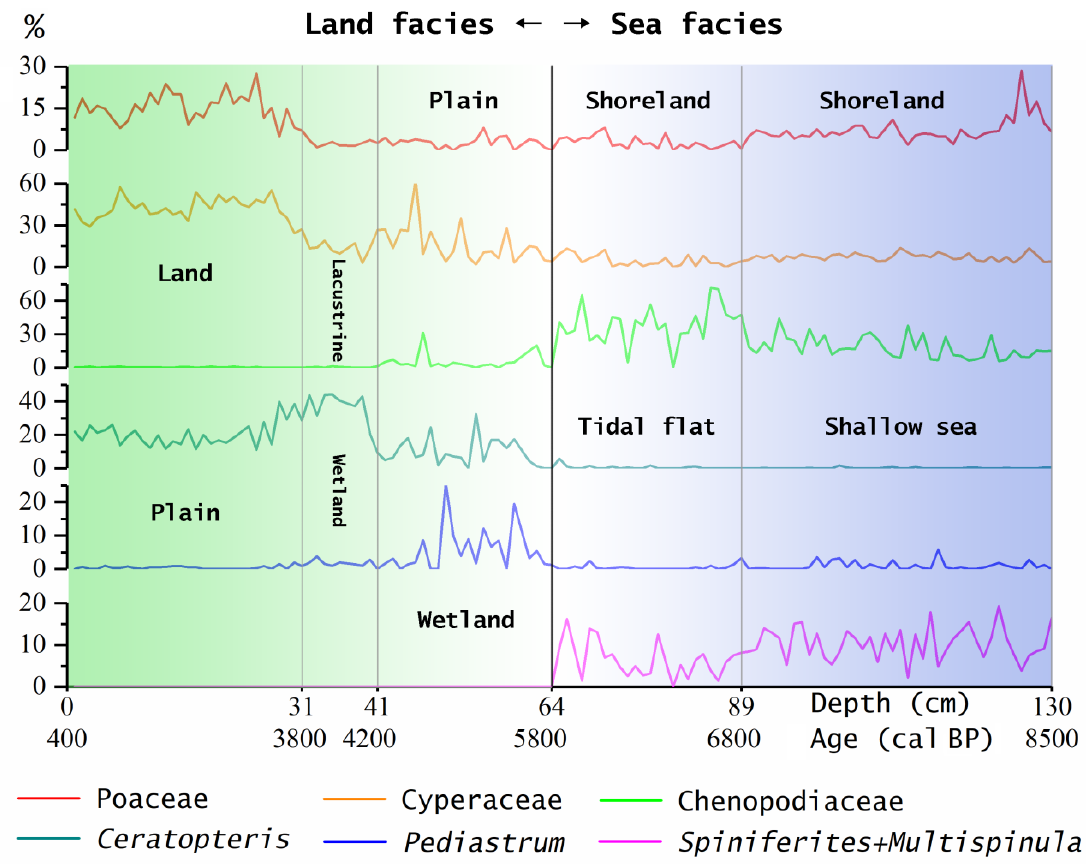
Figure 4. Pollen percentage of some aquatic algae and terrestrial herbs of the GX2 section and geomorphic evolution.